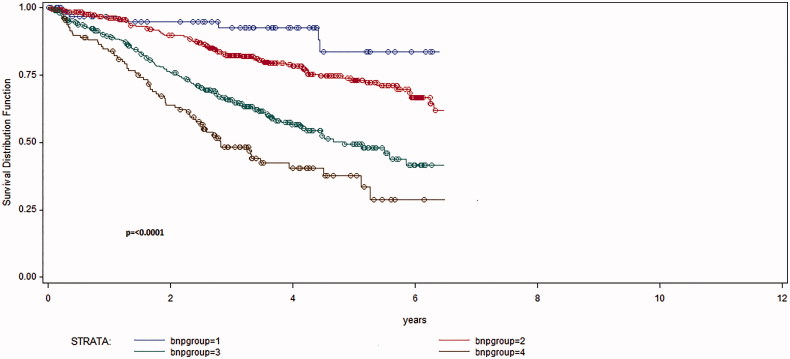
Kaplan–Meier survival curves illustrating all-cause mortality in the four NT-proBNP quartiles during follow-up 1100 ± 687 days (p= <0.0001).